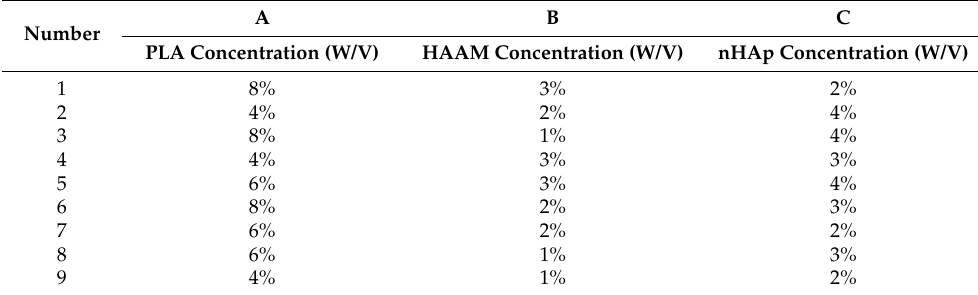
Table 1. Orthogonal